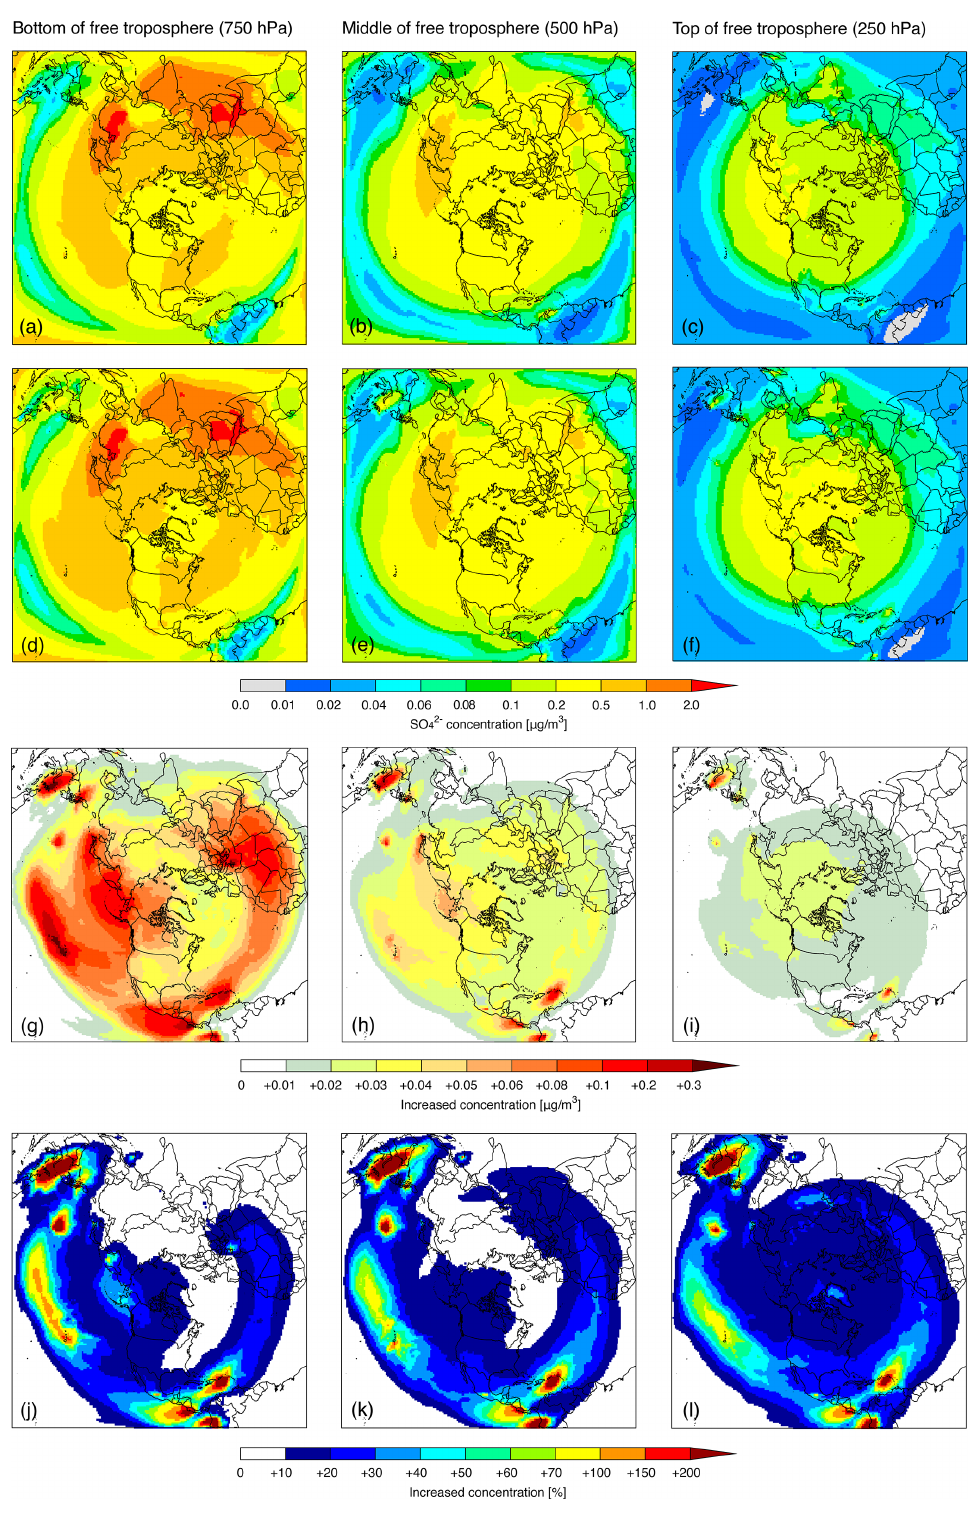
Figure 8. Simulated annual averaged SO 2 − concentration in 2010 by (a–c) original H-CMAQ and (d–f) H-CMAQ with incorporation of 4 volcanic SO 2 emissions, (g–i) increased concentration by the incorporation of volcanic SO 2 emissions, and (j–l) same as (g–i) but shown as relative percentage at the bottom of the free troposphere (750hPa; a , d , g , j ), middle of the free troposphere (500hPa; b , e , h , k ), and top of the free troposphere (250hPa; c , f , i , l